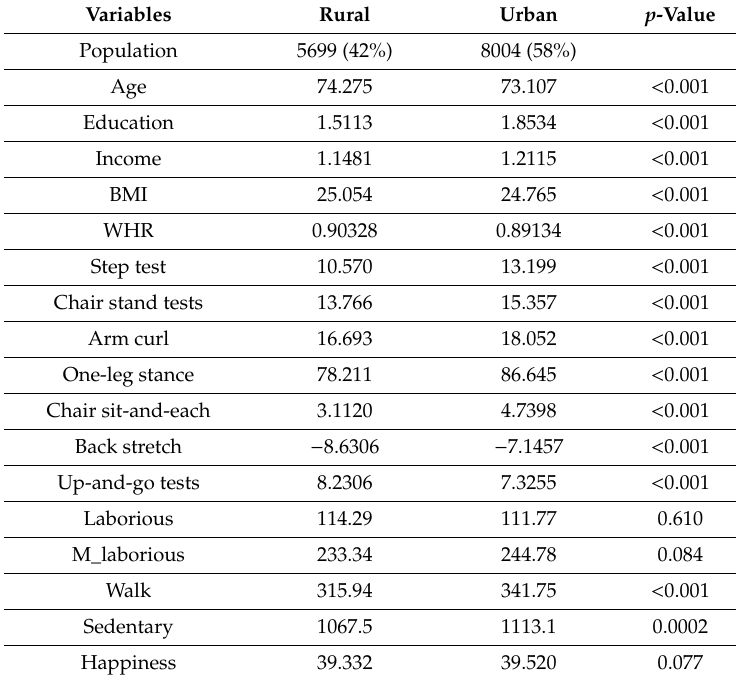
Table A2. t -tests analysis based on living alone